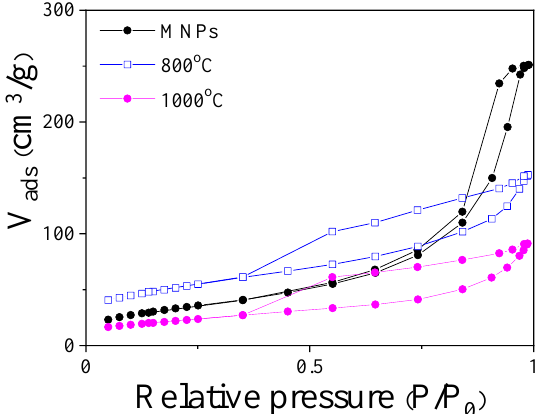
Figure 7. Nitrogen adsorption–desorption curves at 77 K for the MNPs and the annealed sample (MNPs + fructose) at 800 °C and 1000 °C.